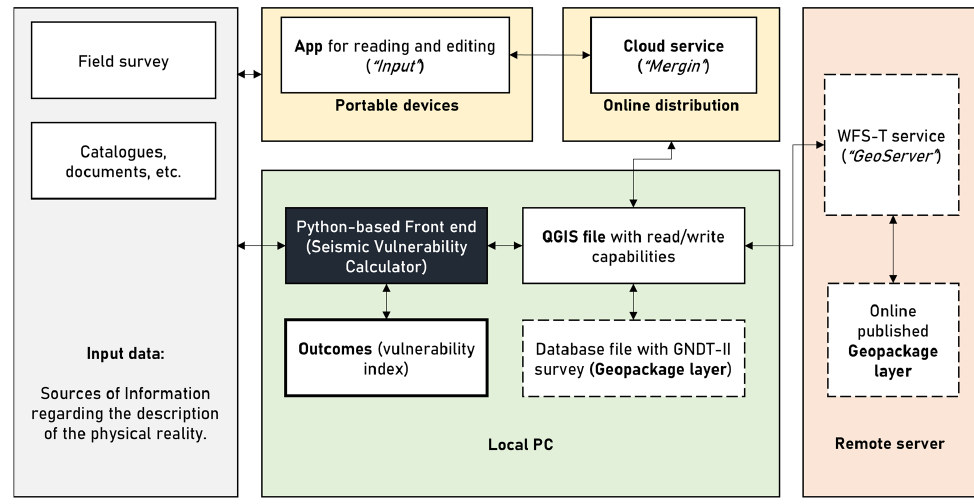
Figure 2. Integrated data flow on GIS databases for VIM surveys.